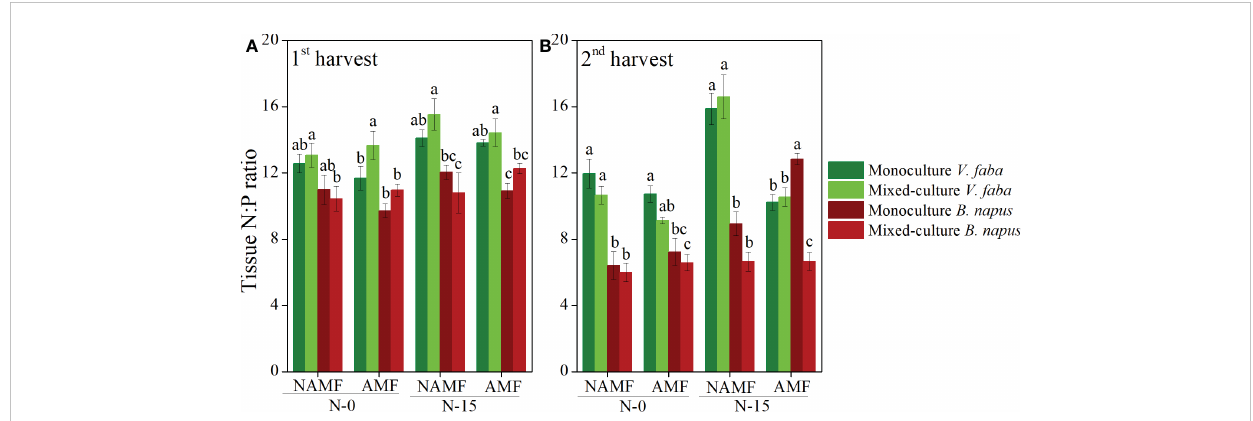
FIGURE 3 Tissue N:P ratio per plant (mean ± SE) in monoculture and mixed-culture V. faba and B. napus under AMF inoculation and N-addition conditions of N-0 and N-15. (A) shows 1st harvest, (B) shows 2nd harvest. Different letters denote signi fi cantly different means (Duncan test: P < 0.05). For statistical details, see Table 2 and Supplementary Table